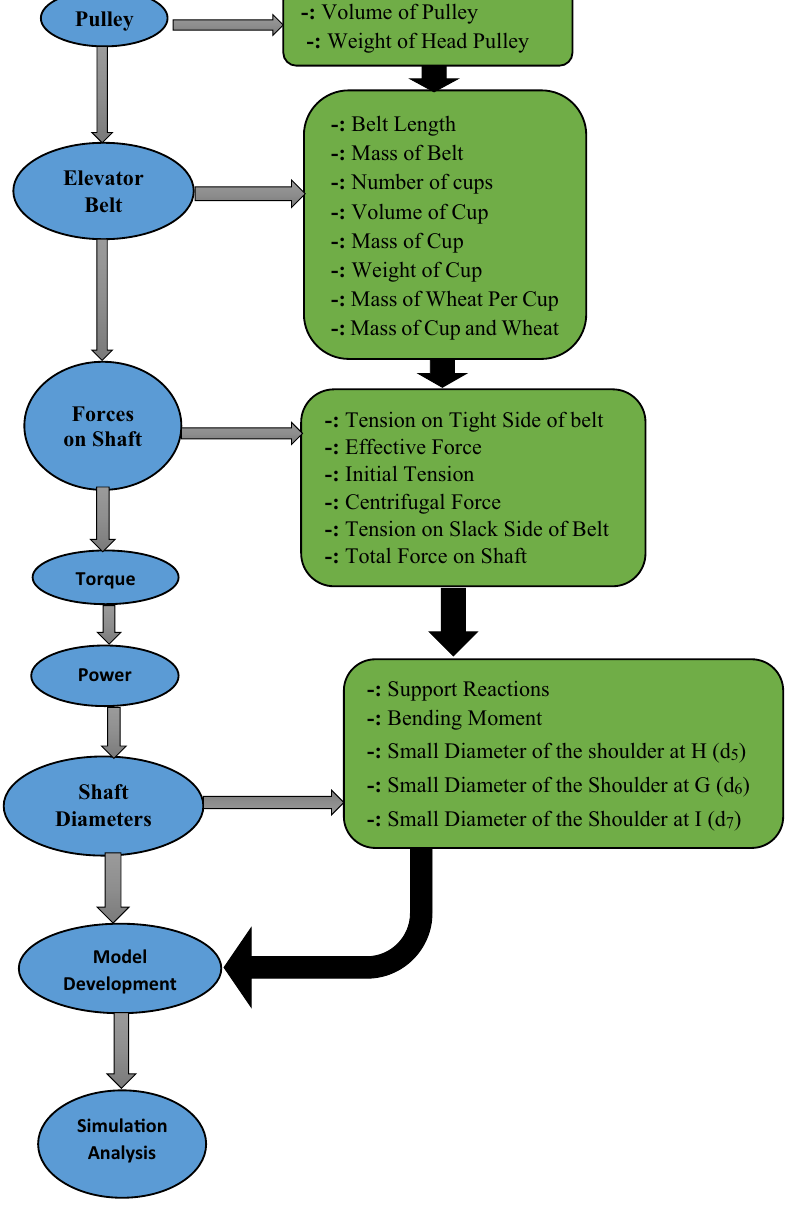
Figure 3. Graphical representation of the